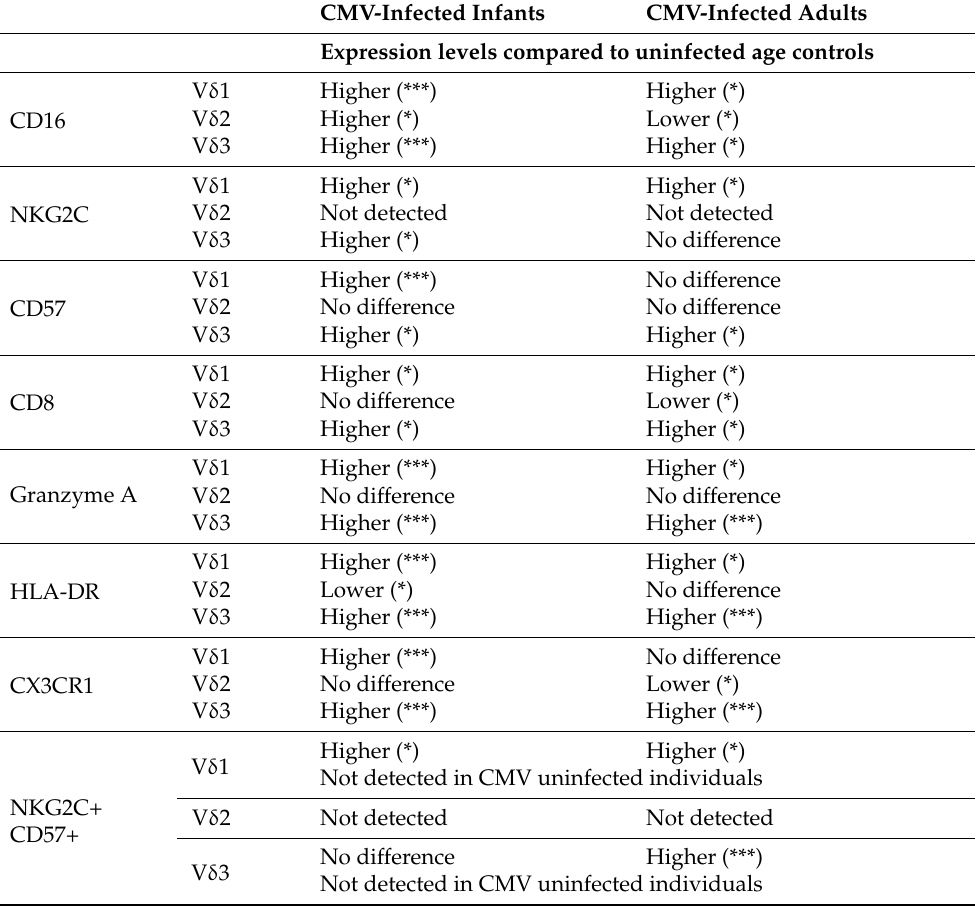
Table 1. Phenotypic differences of γδ T cell δ -subsets between CMV-infected and CMV-uninfected infants and adults. Expression levels of phenotypic activation markers on δ -subsets obtained by spectral flow cytometry from CMV-infected subjects were compared to CMV-uninfected age controls. Infant subjects were from Ugandan birth cohort (2–12 months old; n = 15; CMV-infected n = 8 and CMV- uninfected n = 7) and adult subjects were Canadian ( n = 10; CMV-infected n = 5 and CMV-uninfected n = 5) and Ugandan mothers ( n = 11; all CMV-infected). Statistical differences between CMV-infected and -uninfected infants and adults were determined using a Wilcoxon–Mann–Whitney